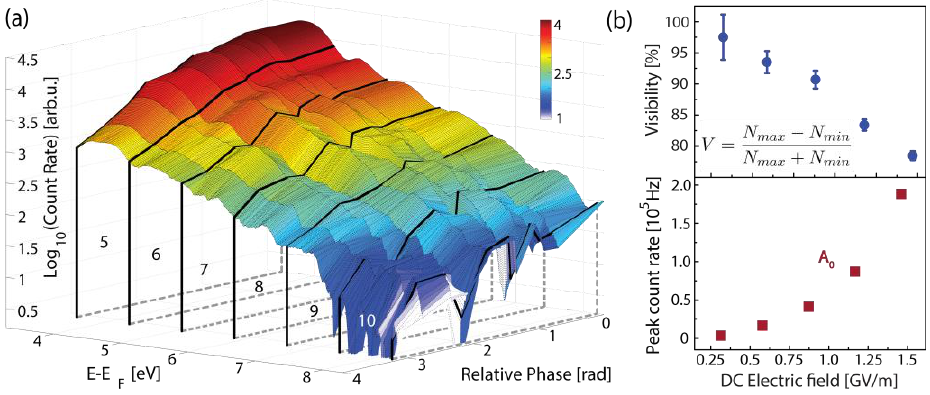
Fig. 2. (a) Two-color phase-dependent electron energy spectra. All above-threshold photon orders show a similar exponential drop in count rate towards higher energies for all two-color phases and the same phase-dependent modulation. (b) Modulation visibility V of the photoemitted electrons and scaling of the DC part of the photoemission signal for different DC electric